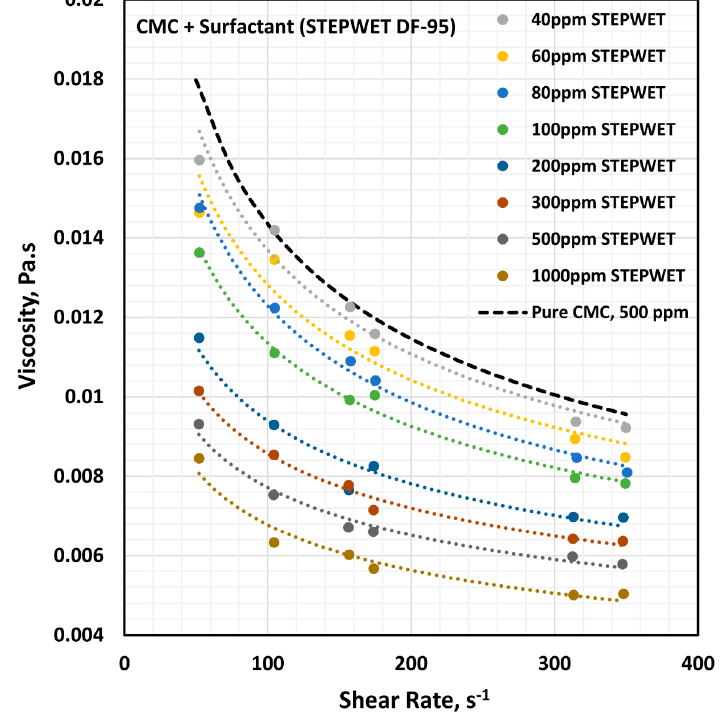
Figure 5. Effect of anionic surfactant (Stepwet DF-95) on the viscosity versus shear rate behavior of solutions of mixtures of the anionic polymer, CMC, and the anionic surfactant, Stepwet DF-95, at a fixed polymer concentration of 500 ppm.